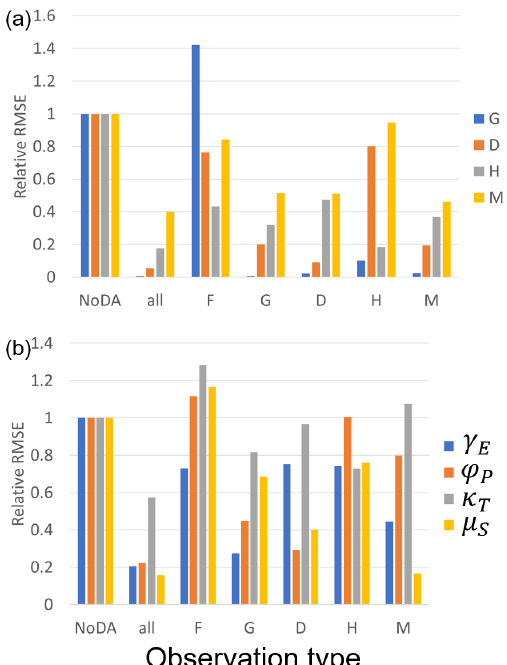
Figure 8. The ratio of the RMSEs of the no data assimilation (NoDA) experiment to those of the data assimilation (DA) exper- iments in which all of observations ( F , G , D , H , and M ) are assim- ilated (all), and each one of them is assimilated in experiment 2 (see Sect. 3.1.2). (a) Blue, orange, gray, and yellow bars are RMSEs of the size of the human settlement G(t) , the center of the mass of the human settlement from the river D(t) , the flood protection level (or levee height) H(t) , and the social awareness of the flood risk M(t) . (b) Blue, orange, gray, and yellow bars are RMSEs of the cost of levee raising γ E , the rate at which new properties can be built ϕ P , the rate of decay of levees κ T , and the memory loss rate µ S .